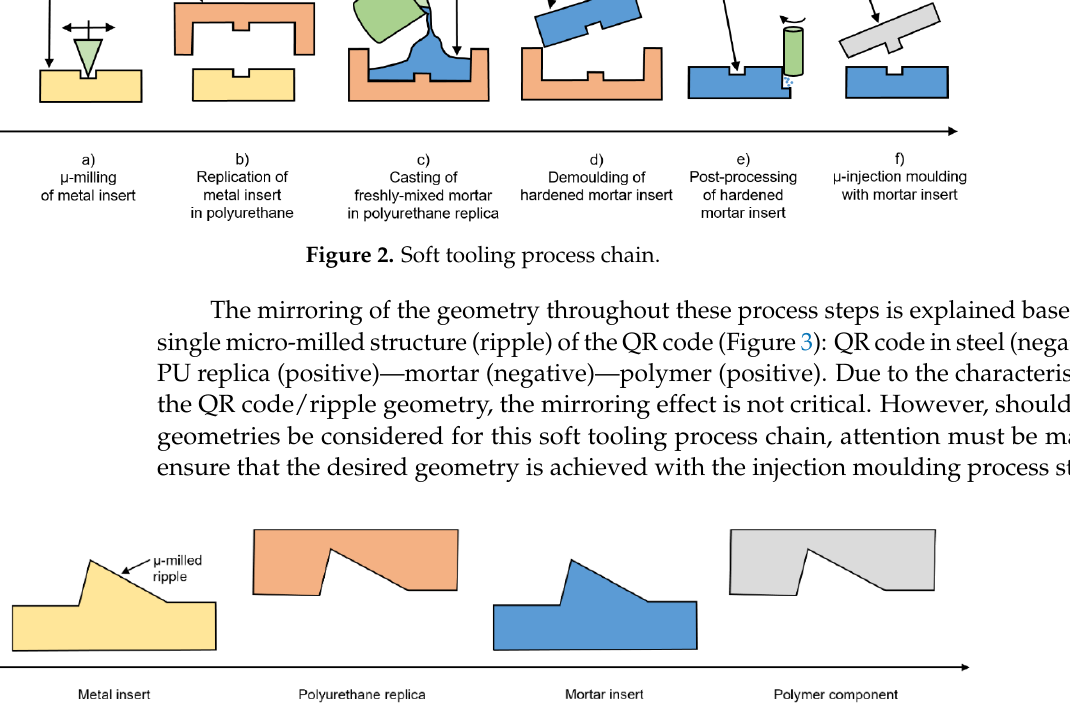
Figure 2. Soft tooling process chain.